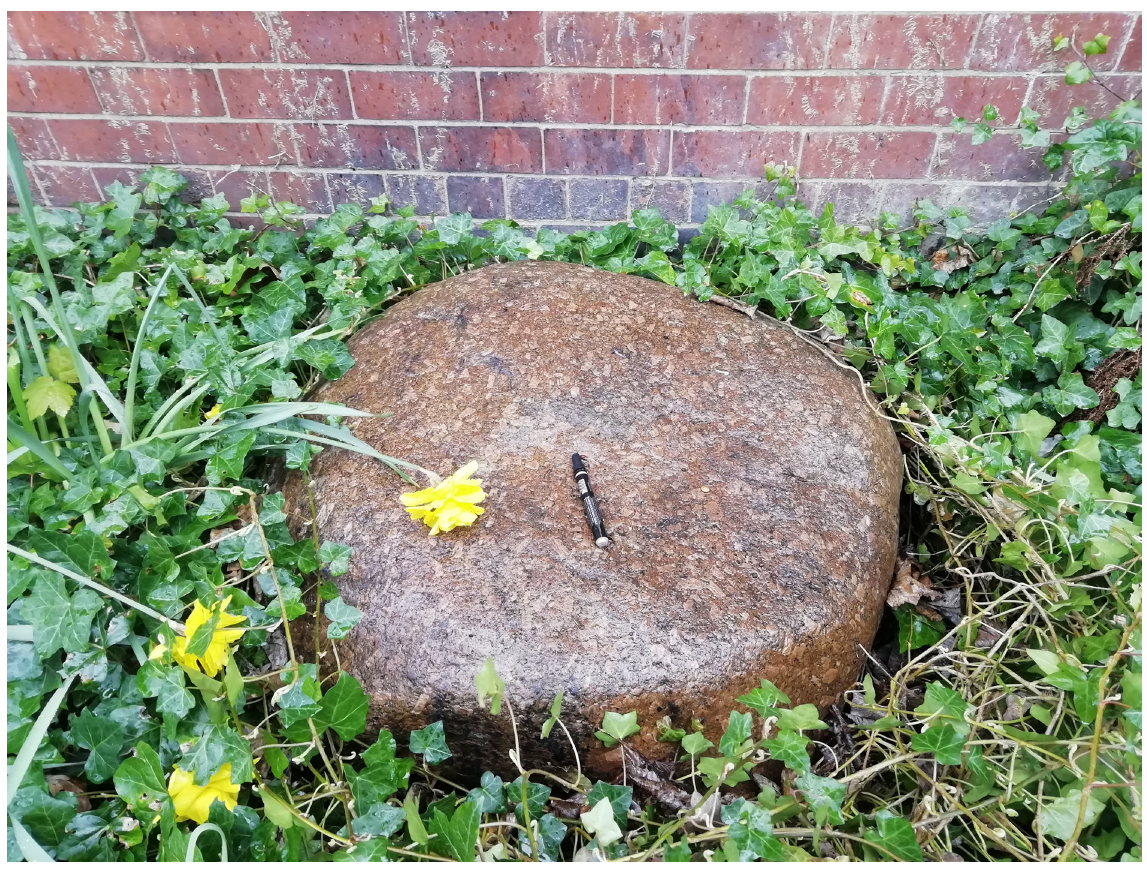
Figure 2. An erratic bock of a distinctive granite sourced from Shap Fell in north-west England now incorporated in the land- scaping of the University of Leeds campus. The origin of this block is over 130 km northwest of its present